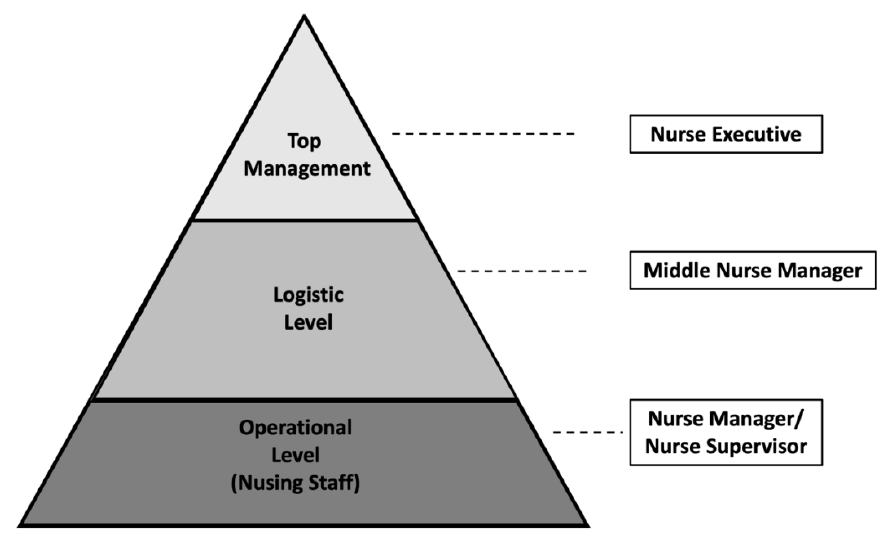
Figure 1. Management levels. Source: own elaboration.